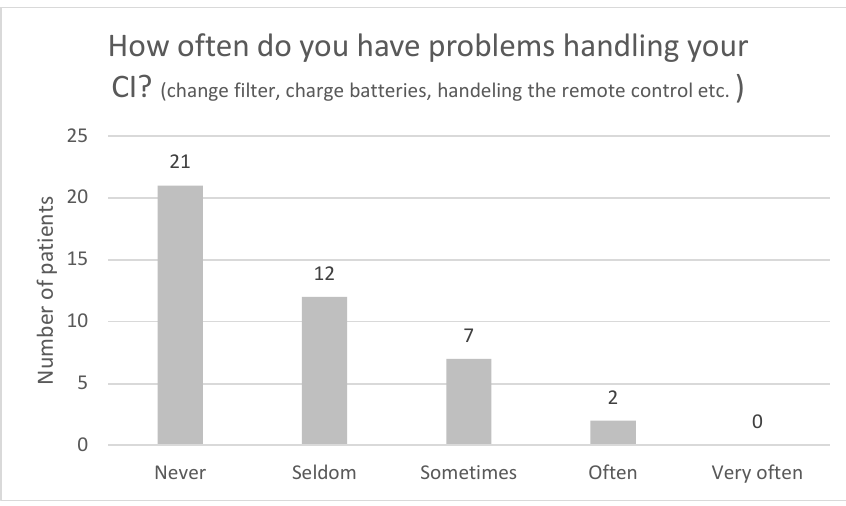
Figure 6. How has your CI influenced your joy of living?